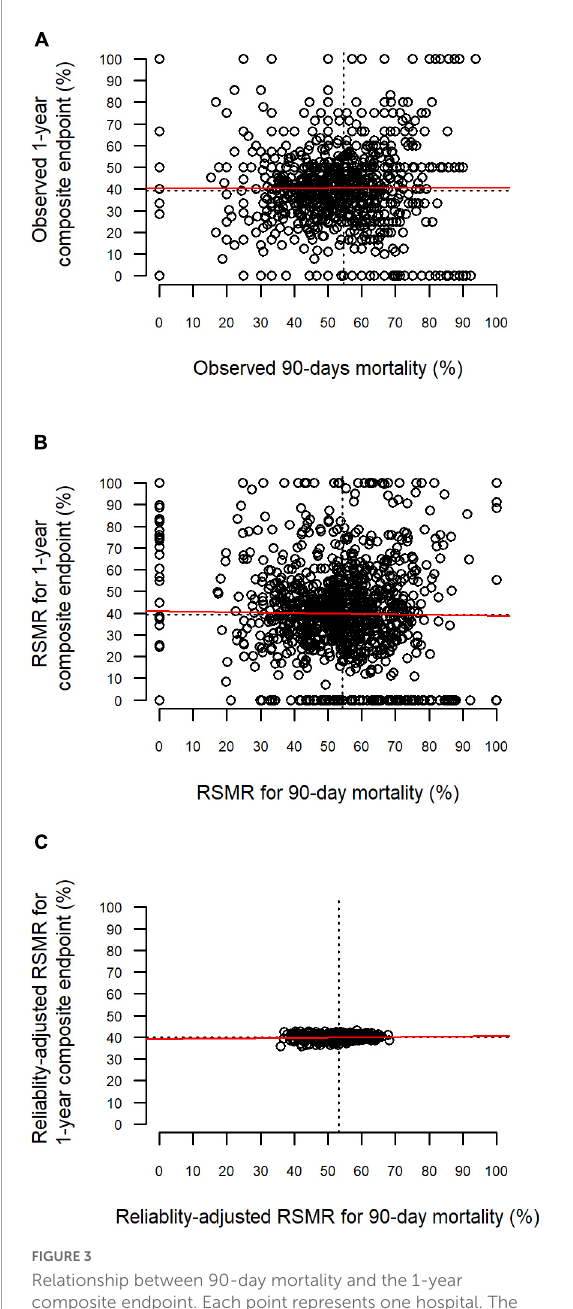
FIGURE3 Relationship between 90-day mortality and the 1-year composite endpoint. Each point represents one hospital. The red line represents the linear relationship based on least-squares estimation. One-year composite endpoint defined by death or increased dependency on chronic care during 1 year after discharge. (A) Relationship between observed rates. (B) Relationship between risk-standardized rates (RSMR). (C) Relationship between reliability-adjusted